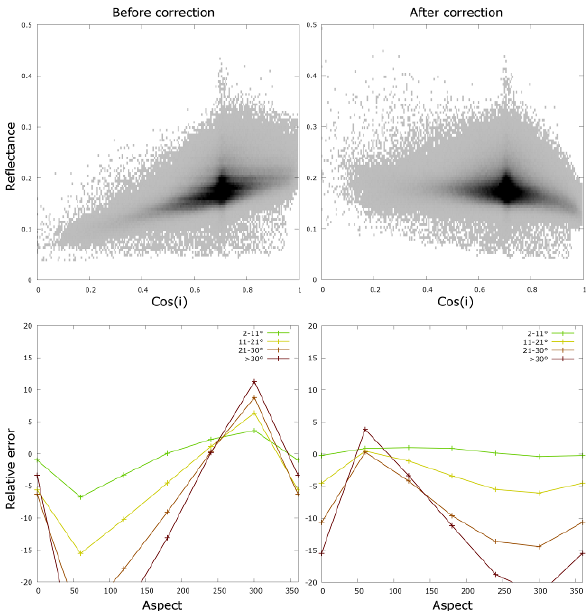
Figure 3. Upper images show reflectance density plot of PROBA-V NIR reflectance in broad-leaf forest land cover class before and after topographic correction. As expected, the reflectance values are flattened out for all the cos(i) values, whereas overcorrection is evident for pixels with high cos(i).